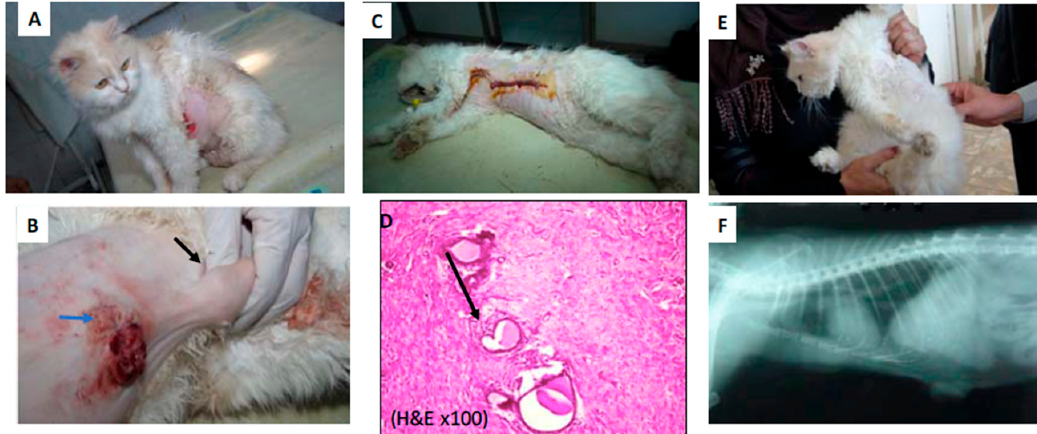
Figure 4. ( A ) A nine-year-old mixed breed cat suffered from mammary neoplasm (Group 2, case 1). ( B ) The sites of tumors at the left axillary lymph node (black arrow) and left cranial thoracic (blue arrow) ( C ) after surgical excision and ( D ) the subcutaneous layer showing well-developed granulation tissue at the site of suture (arrow) (H&E × 100). ( E ) The case after 12 months showed complete recovery from the surgery without any evidence of recurrence. ( F ) X-ray shows no metastasis in the chest. Three images for each tumor were